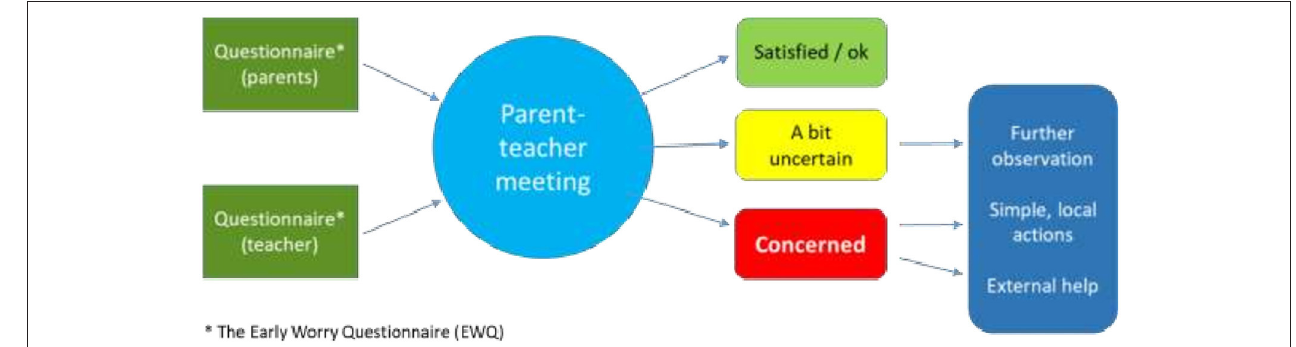
FIGURE 2 | Dialogue based early detection.